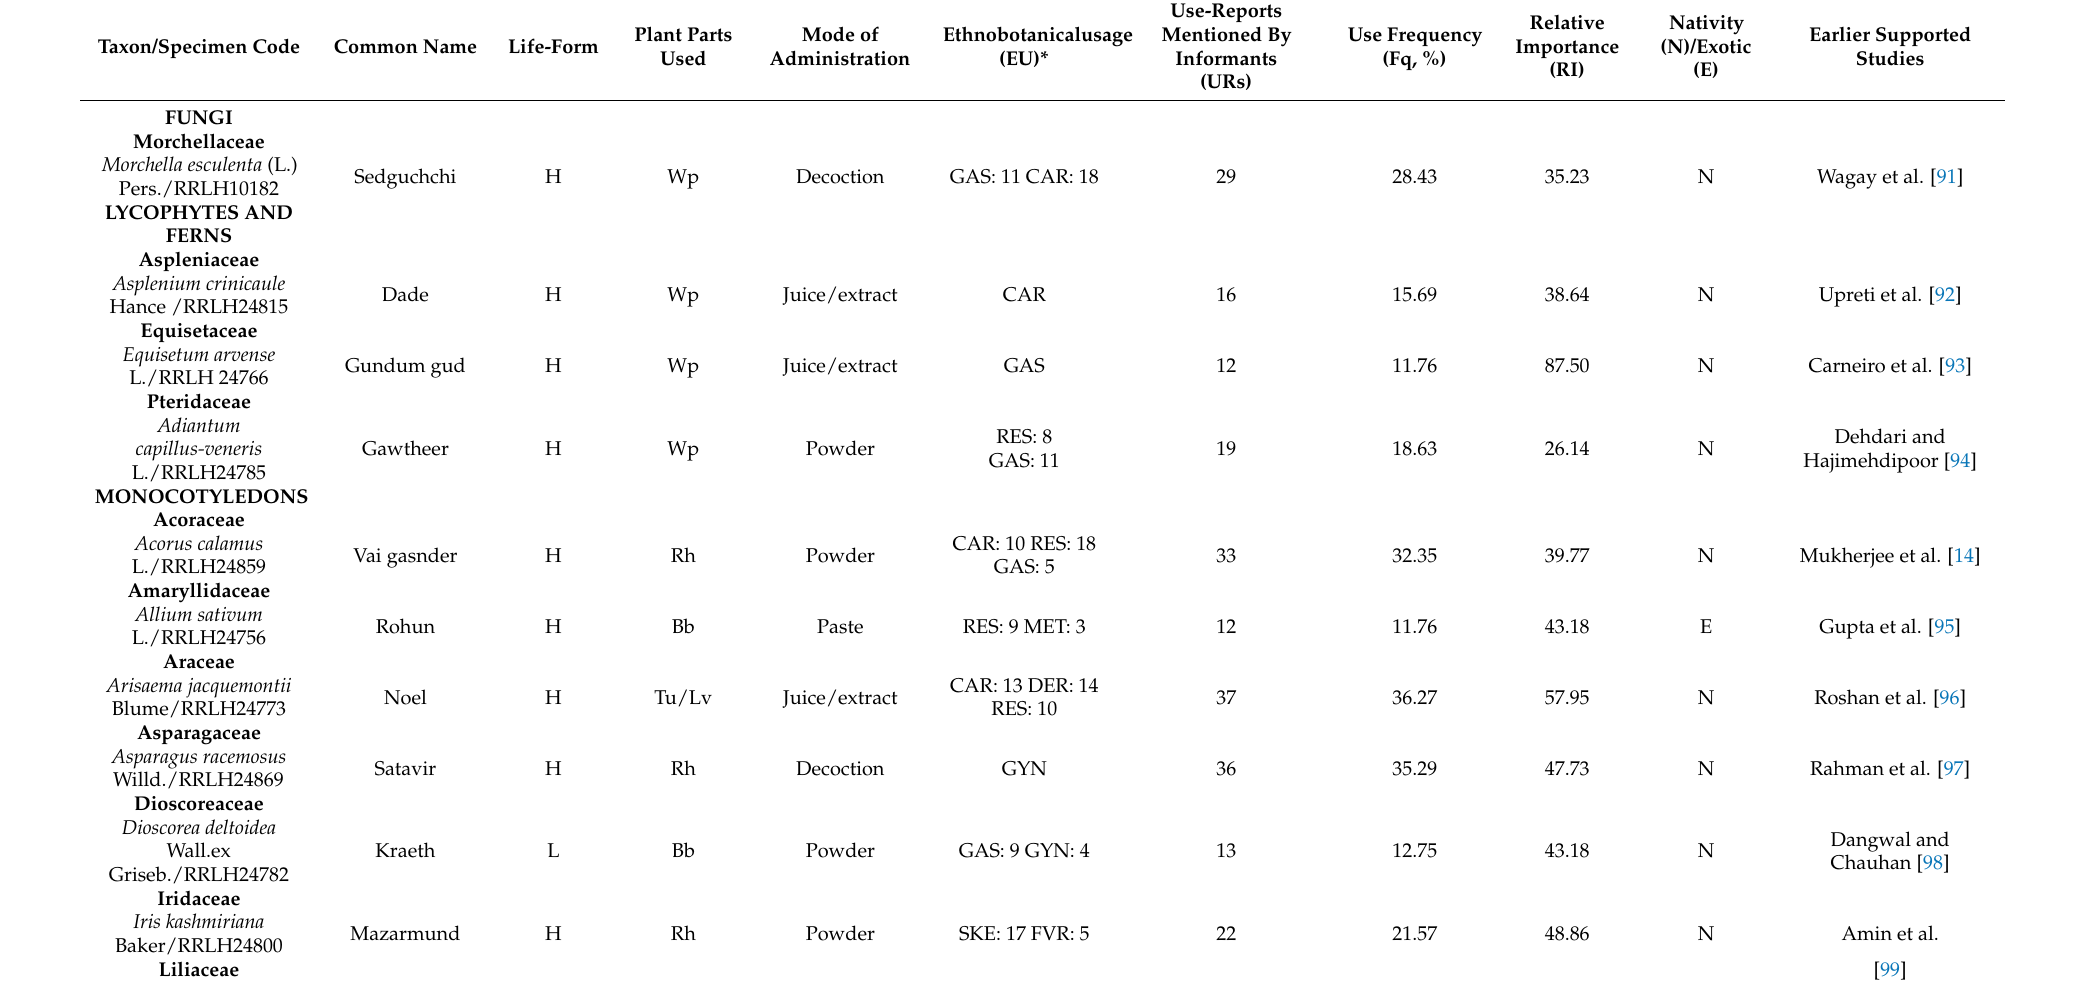
Table 3. Ethnomedicinal plants of the District of Kupwara in the Himalayas,